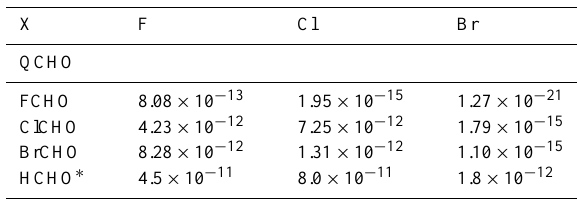
Table 2. Total Rate Constants of the X + QCHO Reactions at